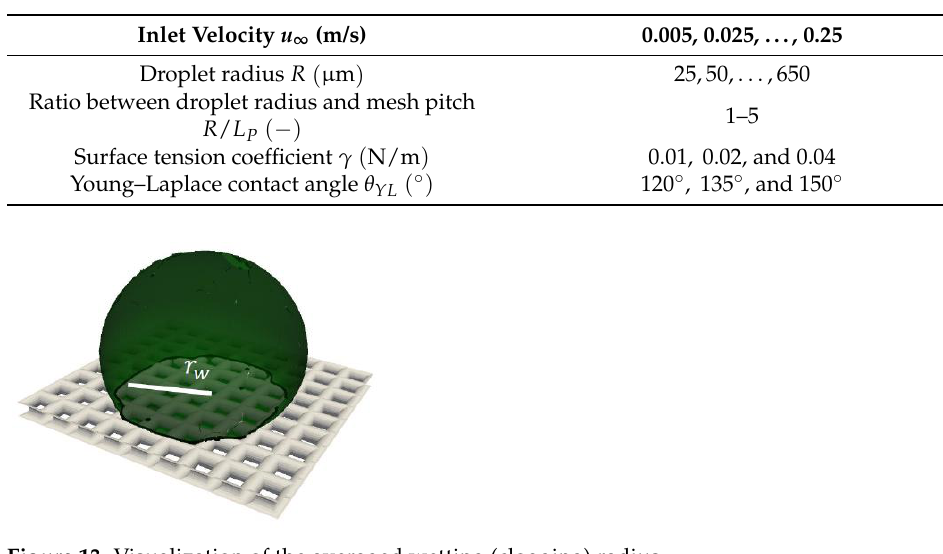
Figure 12. Averaged wetting radius of a droplet on a thin cylindrical fiber. Table 6. Parameter space of the simulations of water–wire mesh screen interaction.